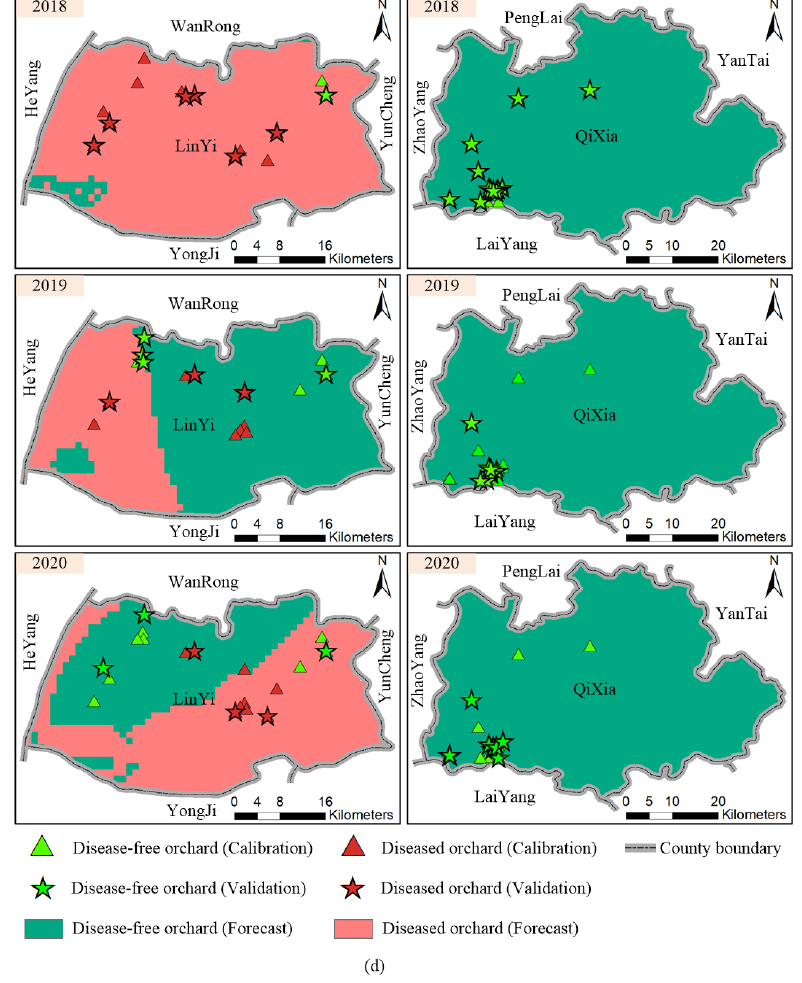
Figure 8. Spatial distribution of forecasted incidence of apple ALS based on meteorological infor- mation under different algorithms, including ( a ) Logistic regression; ( b ) Fisher Linear Discriminant Analysis; ( c ) Support Vector Machines; and ( d ) K-Nearest Neighbors classifier.